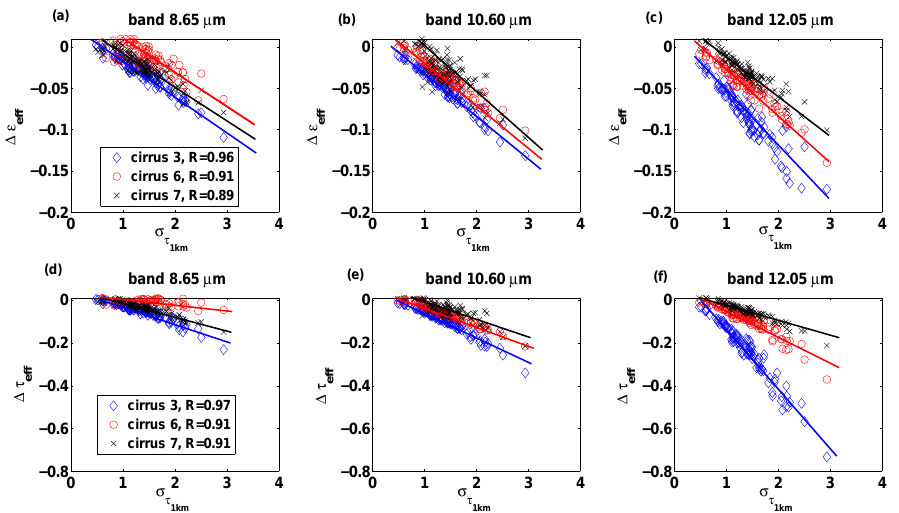
Figure 8. Errors on the effective emissivity (cid:49)ε eff ( a , b and c ) and on the effective optical thickness (cid:49)τ eff ( d , e and f ) at 8.65, 10.60 and 12.05µm, respectively, as a function of the optical thickness standard deviation, σ τ crystal effective diameters: cirrus cases 3 ( D eff = 9 . 95µm), 6 ( D eff = 20.09µm) and 7 ( D eff = 40.58µm), with τ c = 1 . 80 and ρ τ = 0 . 7 for the three cirrus. R represents the correlation coefficient between (cid:49)ε eff ( a , b and c ) and σ τ